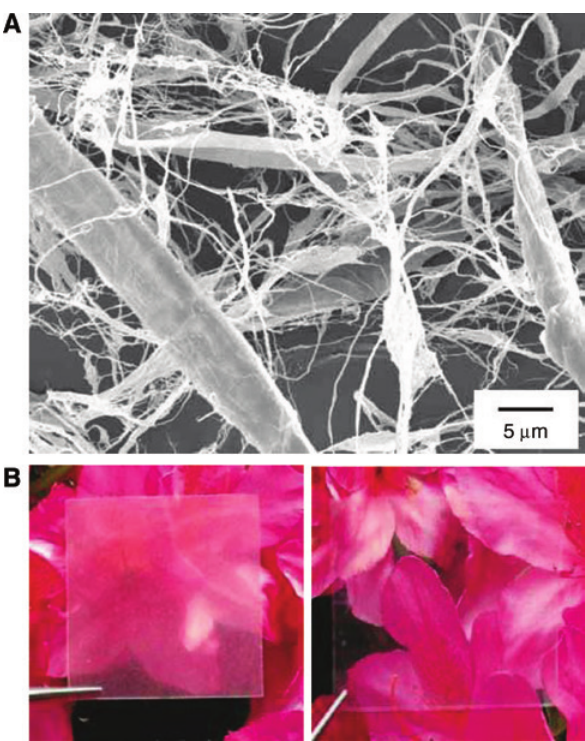
Figure 3: (A) Scanning electron micrograph of 14-times high-pressure homogenizer-treated pulp. (B) Appearance of 53 μ m-thick homogenizer- treated pulp/acrylic resin sheet (left) and 60- μ m-thick bacteria cellulose/acrylic resin sheet (right) [66]. (© 2005 Springer